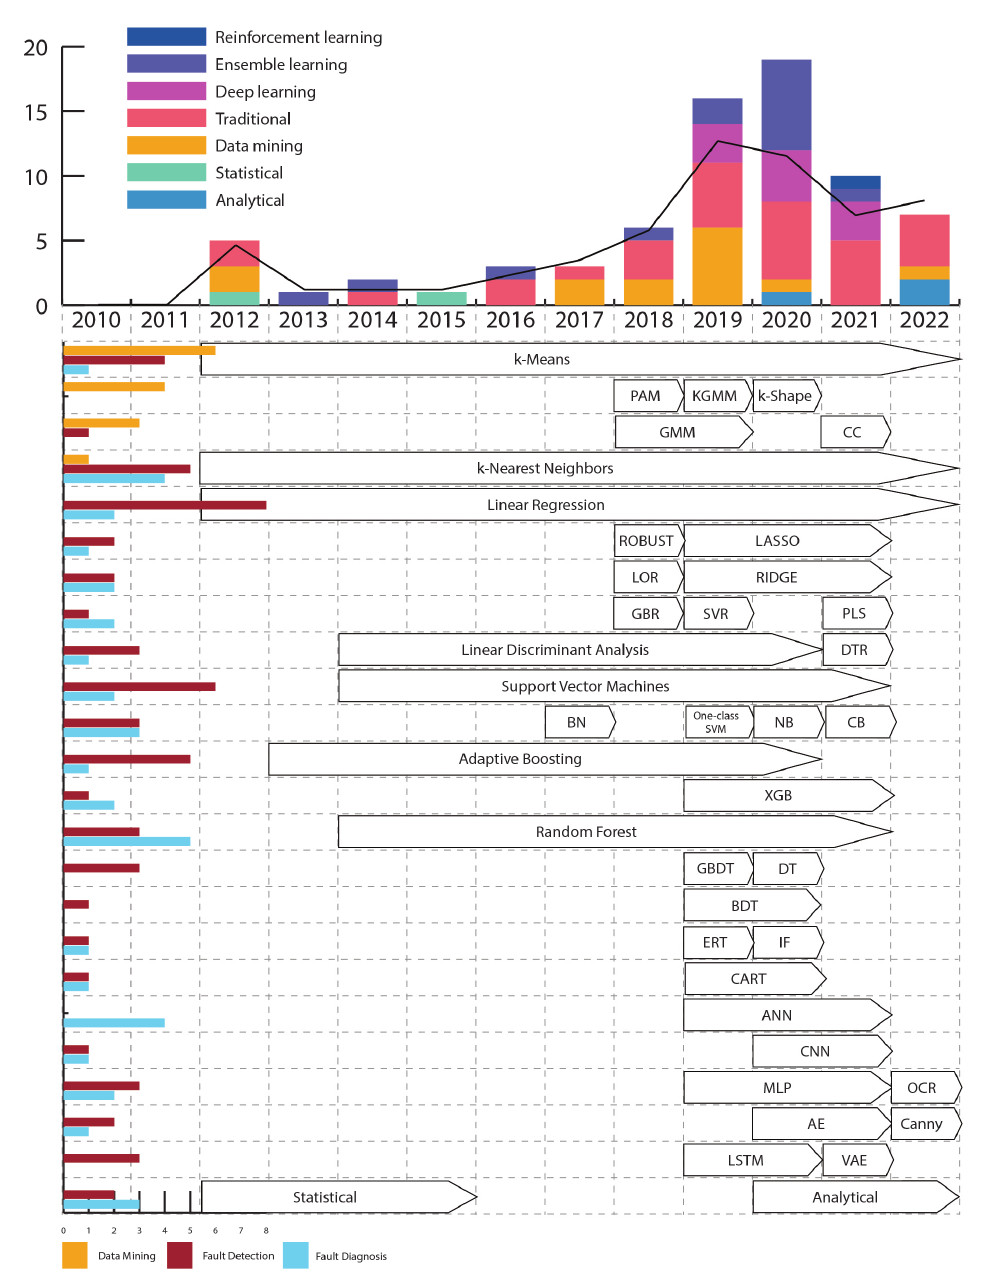
Figure 1. Overview of FDD studies and techniques in